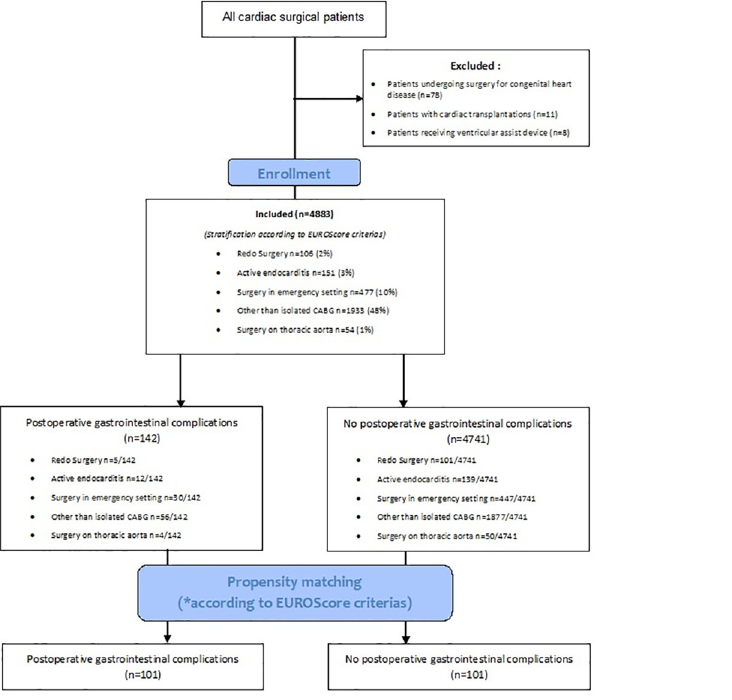
Fig 1. Study flow chart. CABG Coronary artery bypass